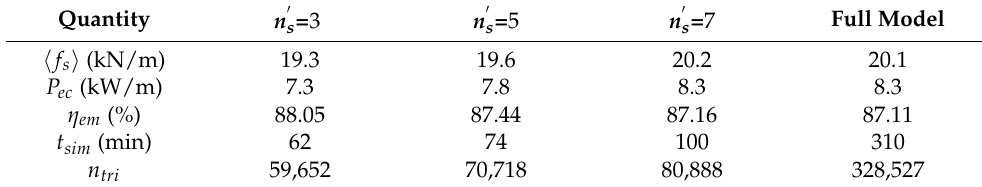
Table 6. Comparison between the results obtained by the reduced and the full